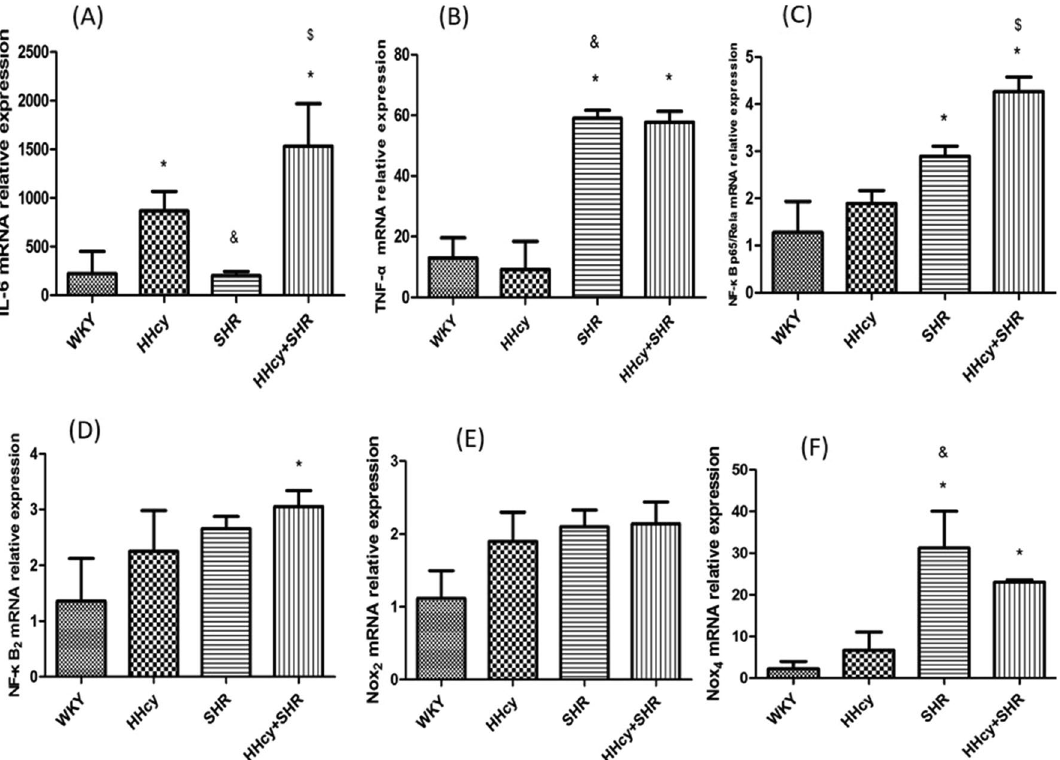
Figure 5. The mRNA relative expression levels of rat aortic tissue in Wistar-Kyoto (WKY) group, hyperhomocysteinemia (HHcy) group, spontaneously hypertensive rat (SHR) group and HHcy + SHR group. ( A ) interleukin-6 (IL-6). ( B ) tumor necrosis factor-alpha (TNF-α). ( C ) nuclear factor-κ-gene binding (NF-κB) p65. ( D ) NF-κB2. ( E ) nicotinamide adenine dinucleotide phosphate oxidase (Nox)2. ( F ) Nox4. Values represent means ± SD ( * P < 0.05 vs. WKY group, $ P < 0.05 vs. SHR group, δ P < 0.05 vs. HHcy group, n =